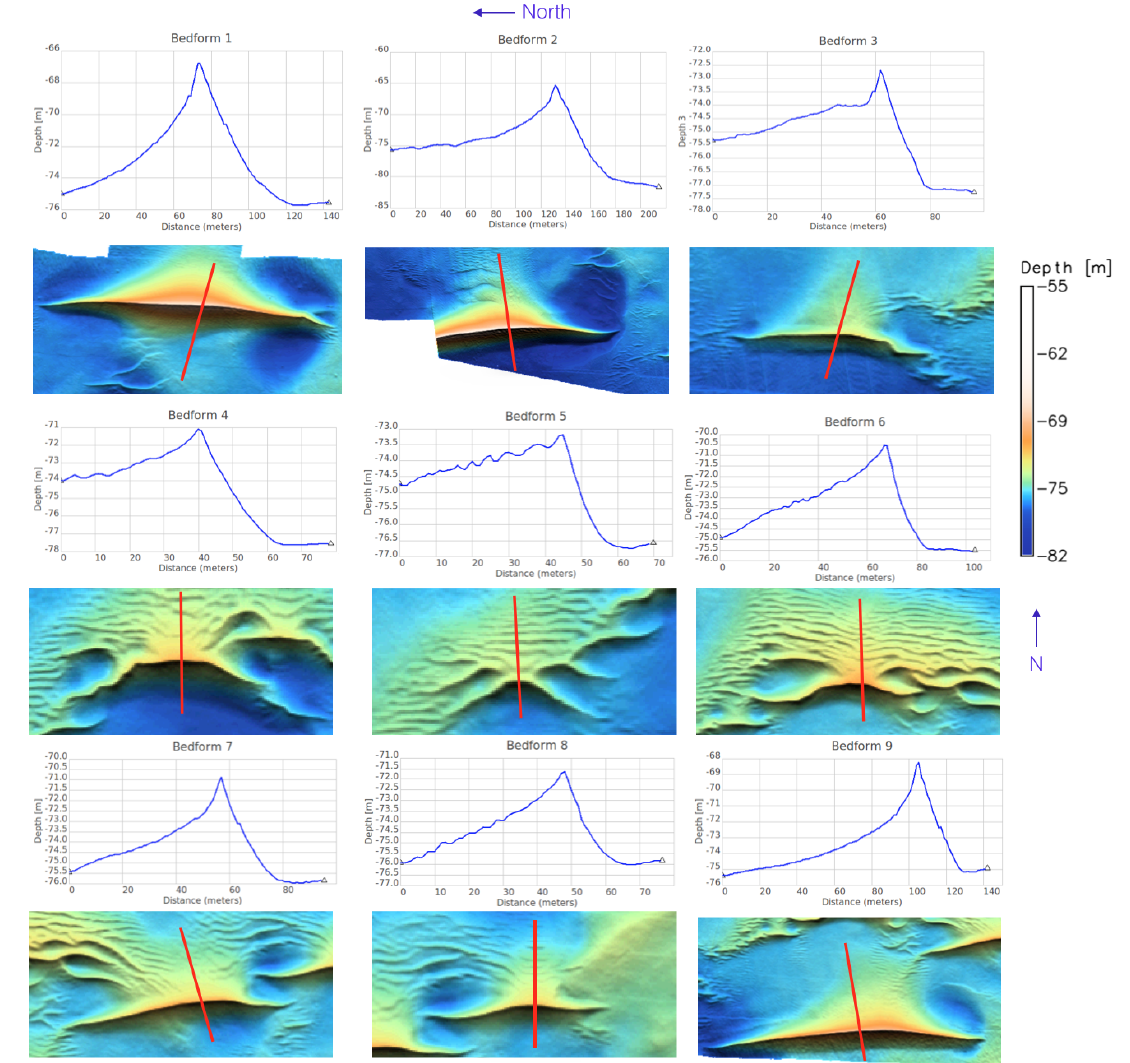
Figure 33. Vertical profiles for the sand waves identified by the r.dune module. From the vertical profiles, it is also possible to observe small differences on the east side of the survey area which is probably due to a larger amount of soft sediment, as can be seen from the acoustic backscatter (BS) collected during the 1998 MBES survey (Figure